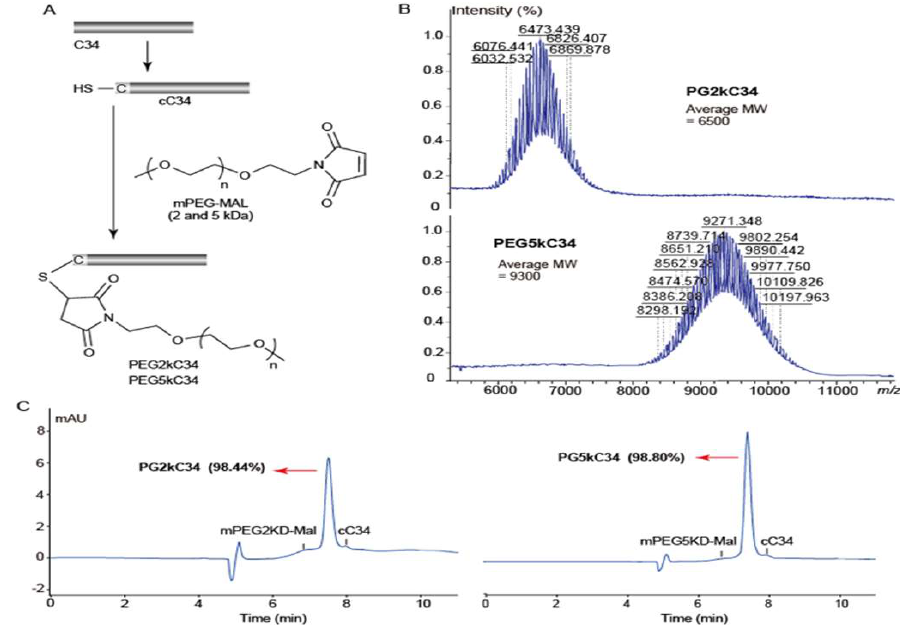
Figure 1. Peptide design, synthesis and identification. Sequence of C34: WMEWDREINNYTSLIHSLIEESQNQQEKNEQELL. The peptide sequences were protected by N-terminal acetylation and C-terminal amidation. ( A ) The flowchart of synthesis PEG2kC34 and PEG5kC34. Reaction conditions: Phosphate bu ff er (pH 7.2), room temperature, 10 min. ( B ) MALDI-TOF mass spectrum analysis of the molecular weight of PEG2kC34 and PEG5kC34. ( C ) HPLC chromatogram analysis of the purity of PEG2kC34 and PEG5kC34. HPLC analyses were performed on an Agilent 1200 system (Agilent, USA) equipped with a UV detector. HPLC chromatographic conditions: Agilent C8 column (4 mm, 9.4 × 250 mm), 40 → 70% CH 3 CN/H 2 O linear gradient at 2.0 mL/min, UV detection at 210 nm.